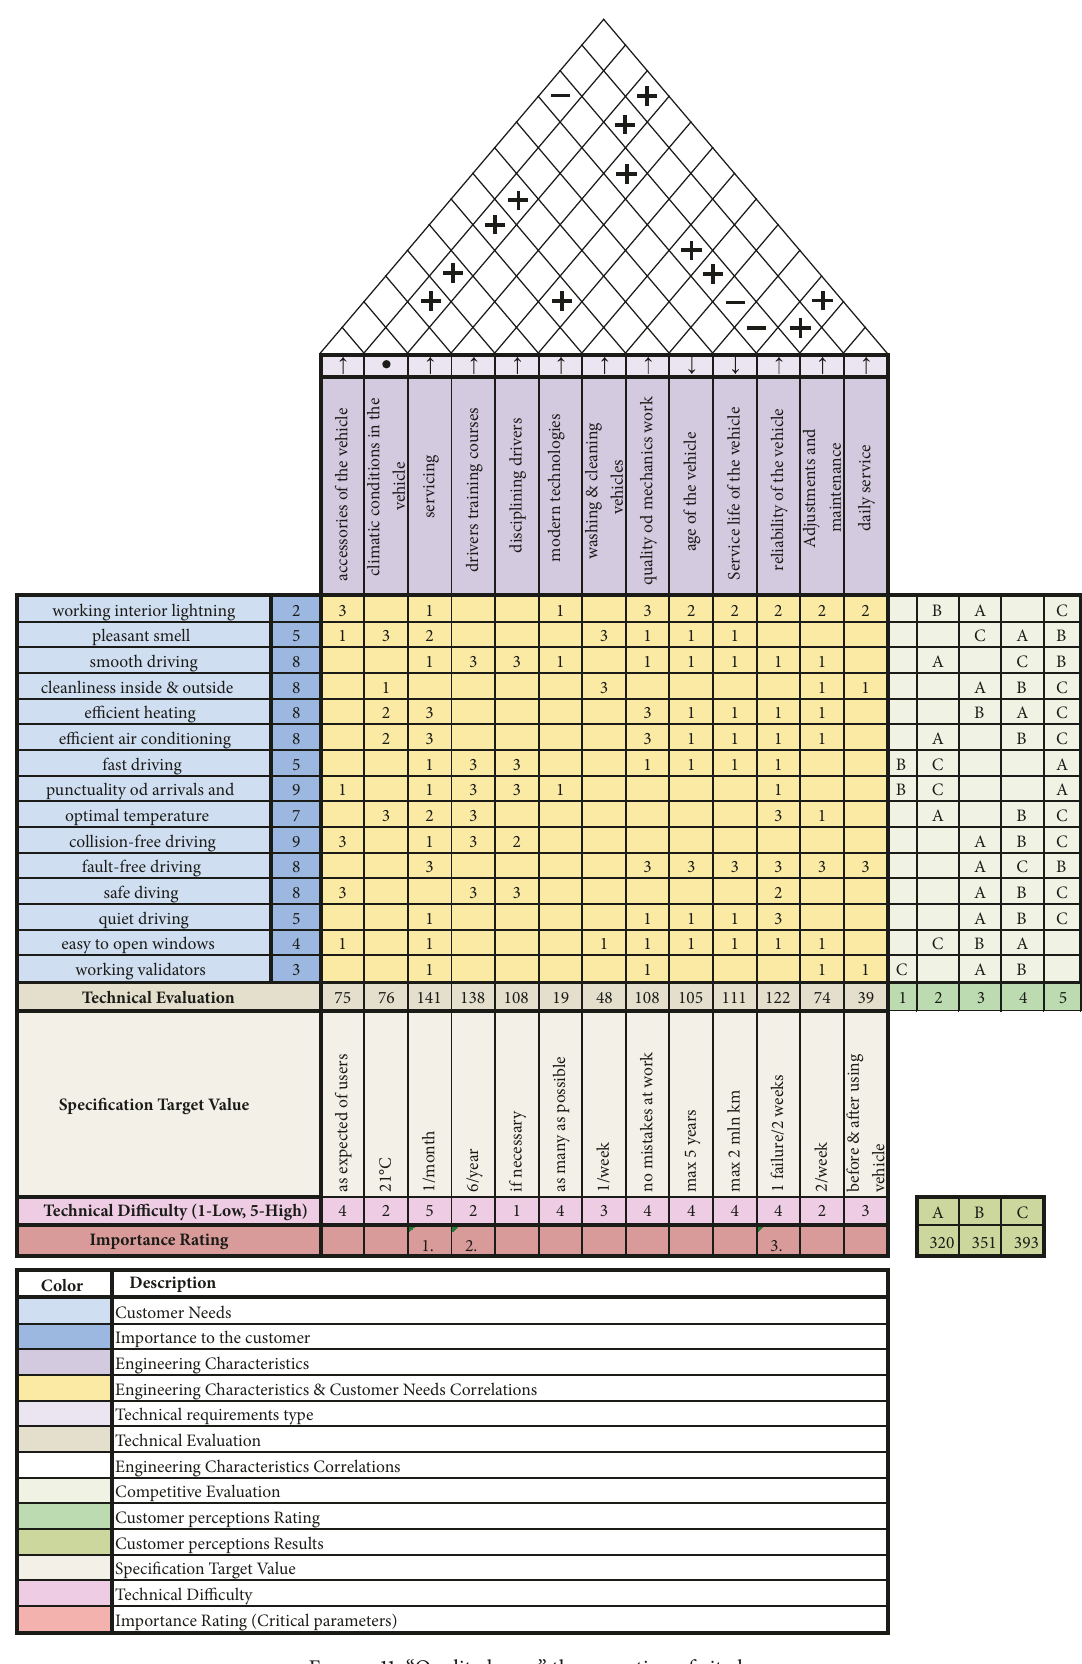
Figure 11: “Quality home” the operation of city